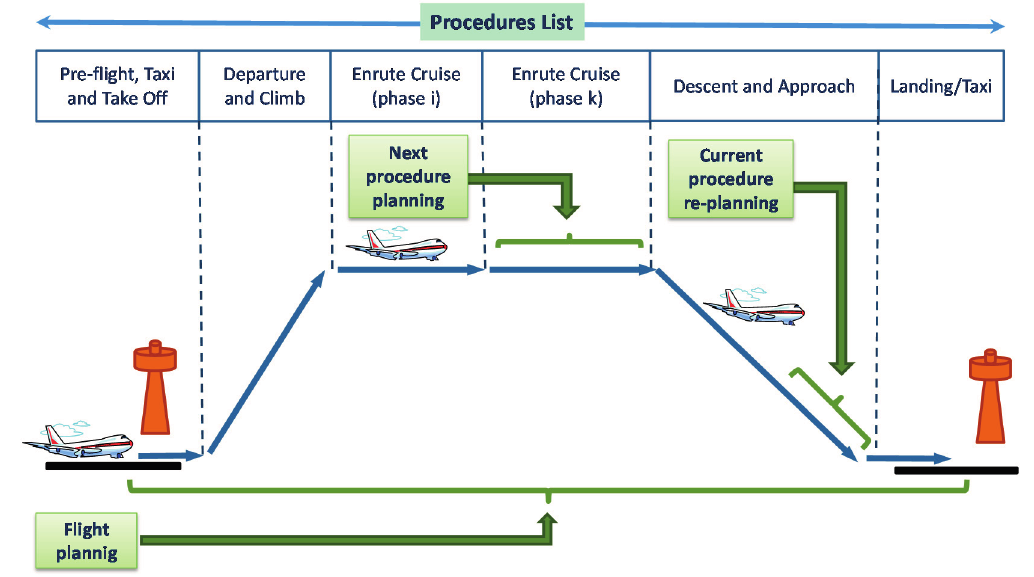
Figure 3. Gate-to-Gate Flight Procedures